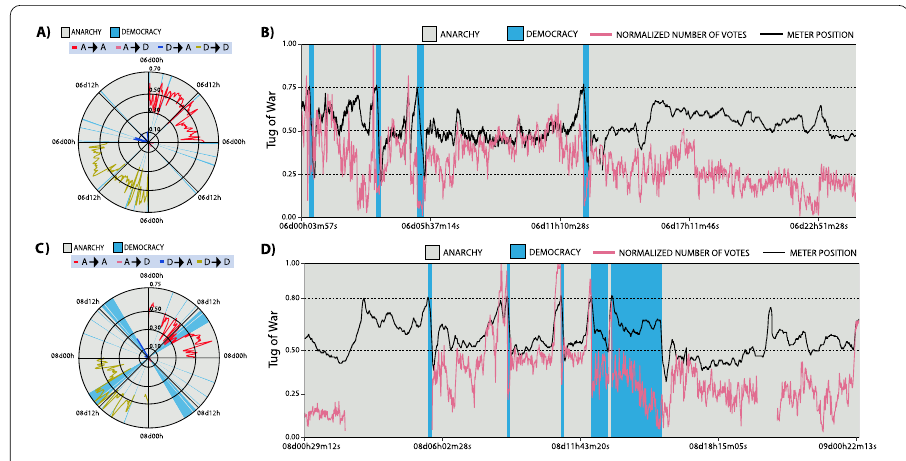
Figure 5 Politics of the crowd. Days 6 (top) and 8 (bottom). In every plot the gray color represents when the game was played under anarchy rules and the blue color when it was played under democracy rules. The polar plots represent the evolution of the fraction of votes corresponding to anarchy/democracy while distinguishing if the user previously voted for anarchy or democracy: first quadrant, votes for anarchy coming from users who previously voted for anarchy ( A → A ); second quadrant, votes for democracy coming from anarchy ( A → D ); third quadrant, votes for democracy coming from democracy ( D → D ); fourth quadrant, votes for anarchy coming from democracy ( D → A ). In the other plots we show the evolution of the total number of votes for anarchy or democracy as a function of time normalized by its maximum value (pink) as well as the position of the tug-of-war meter (black). When the meter goes above 0.75 the system enters into democracy mode (blue) until it reaches 0.25 (these thresholds were later changed to 0.80 and 0.50 respectively) when it enters into anarchy mode (gray) again. The gap in the pink curve of picture ( d ) is due